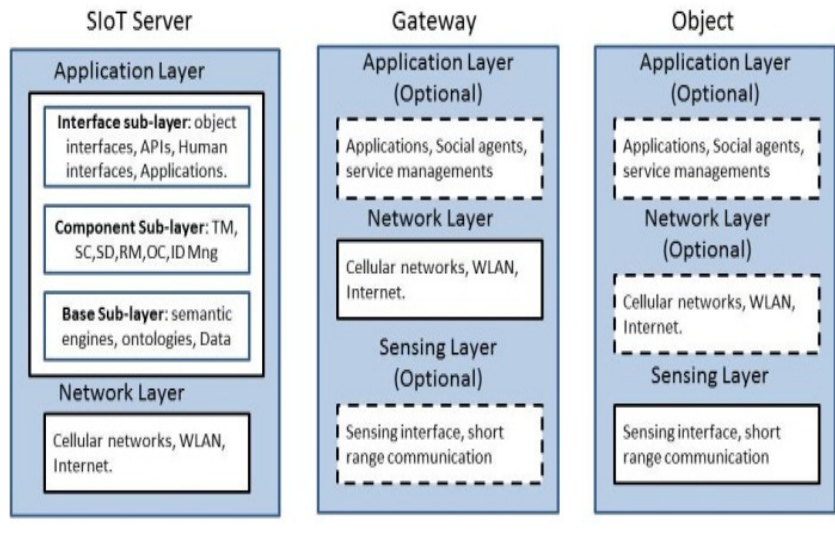
Figure 4. SIoT Figure 4. SIoT Architecture.